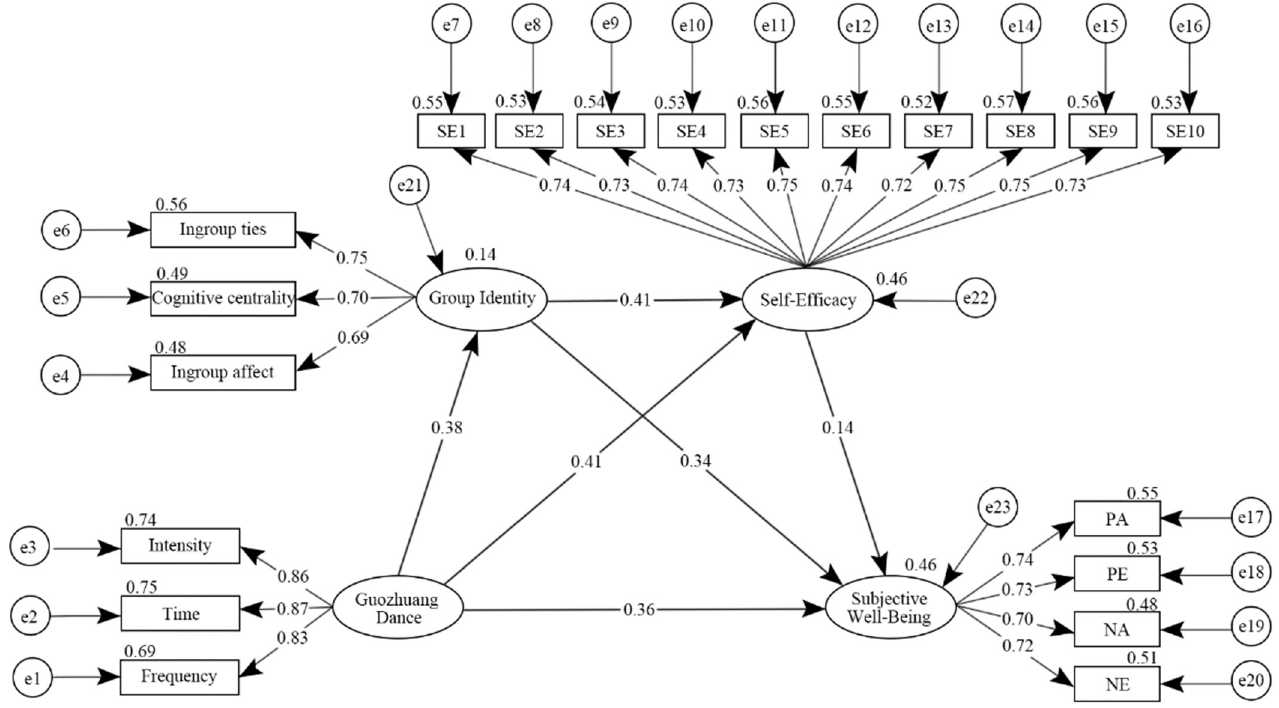
Figure 2. Intermediary model diagram. Note: SE,